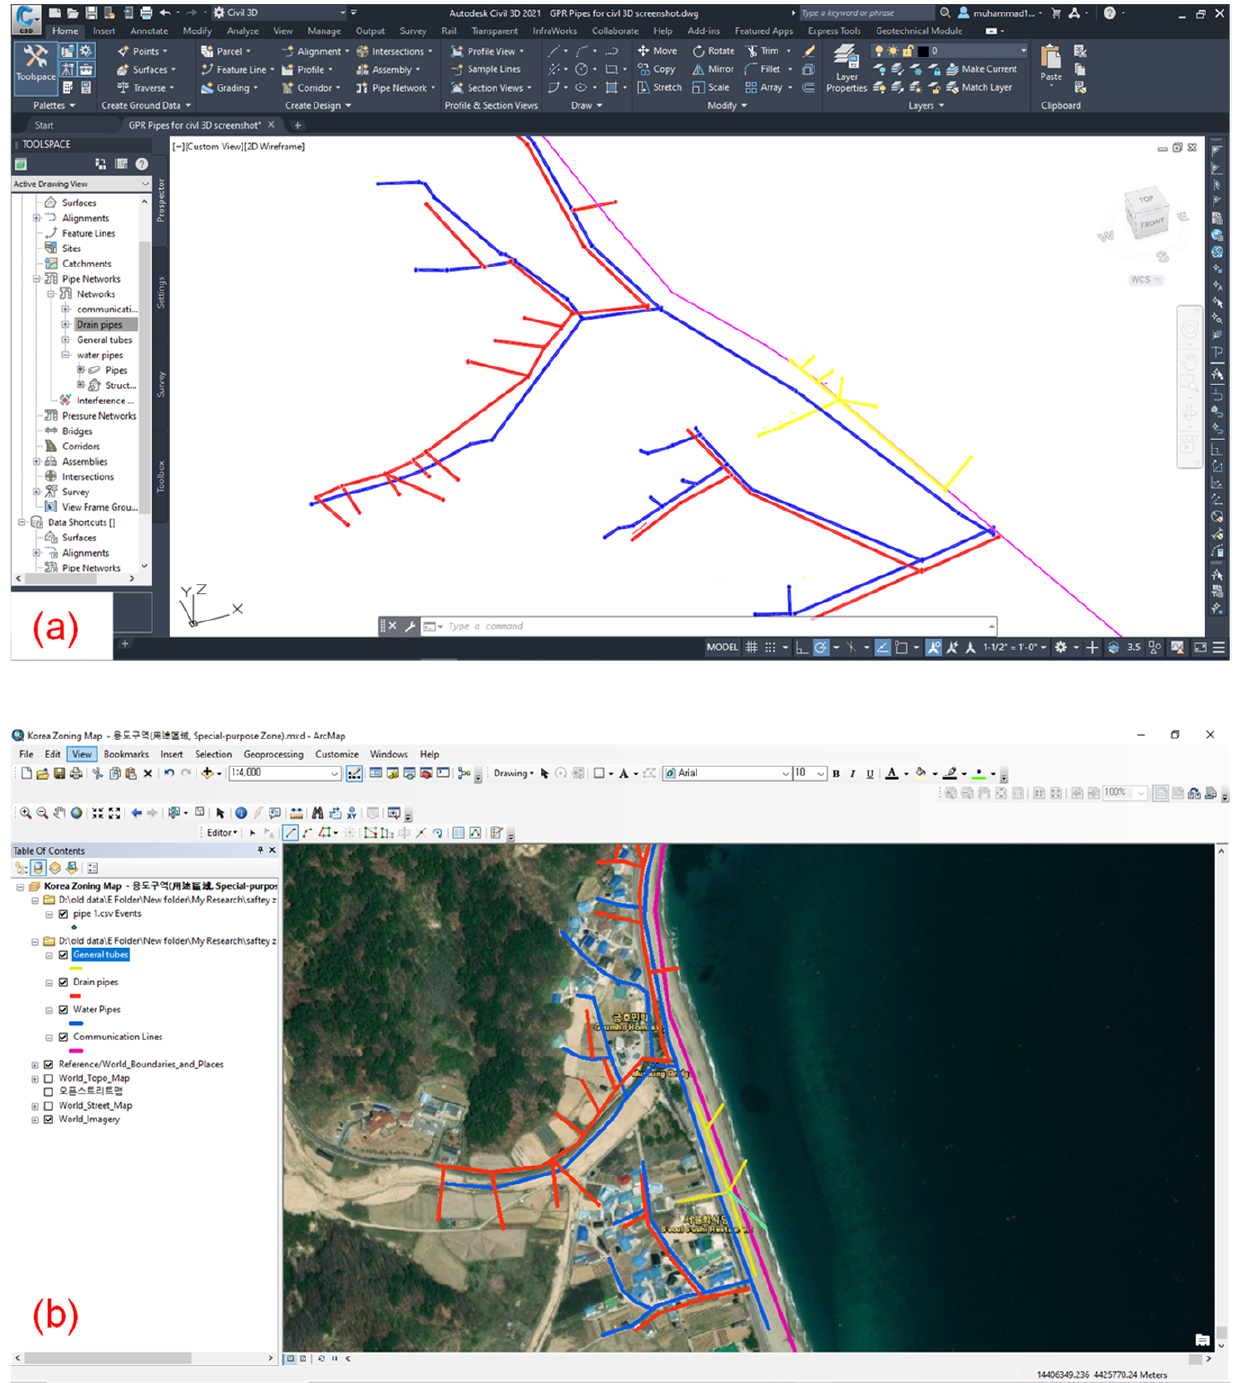
Figure 14. 3D modeling of utility network categorized with different layers: ( a ) utility network models in BIM environment and ( b ) visualization of utility infrastructure system in GIS environ- ment.